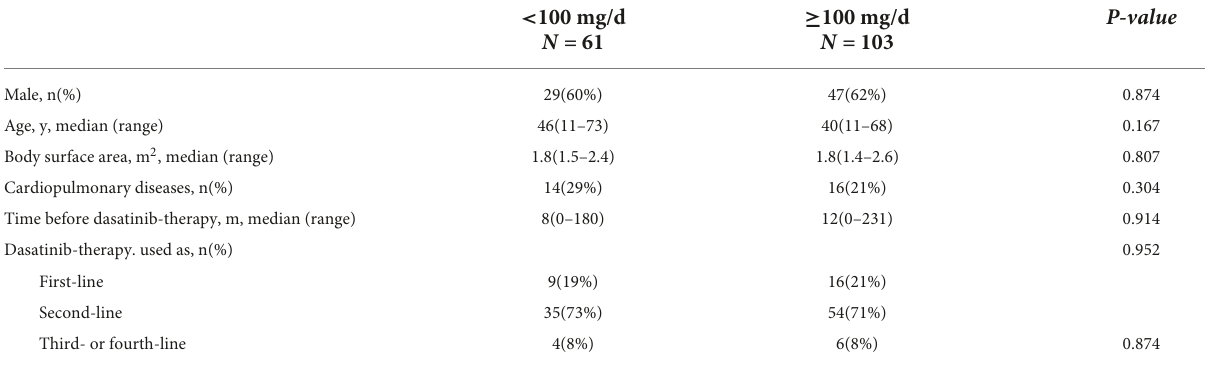
TABLE 6 Patients’ characteristics by propensity score matching analysis in longitudinal